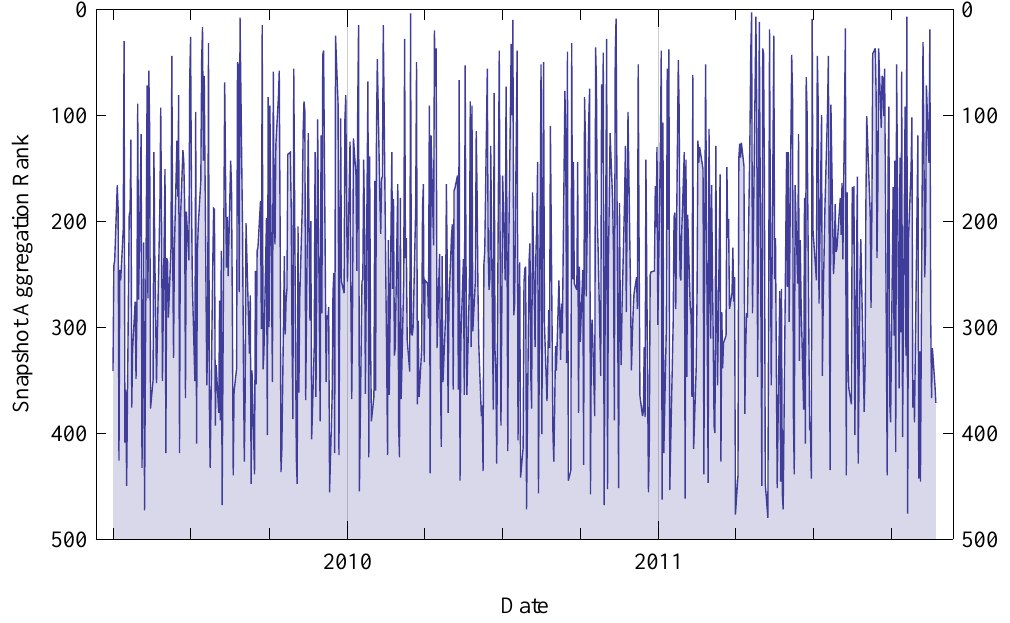
Figure 7. INTC rank as its score (snapshot aggregation) changes over time in a pool of 500 tickers. A lower-numbered rank (visually higher in the graph) means a better stock pick.